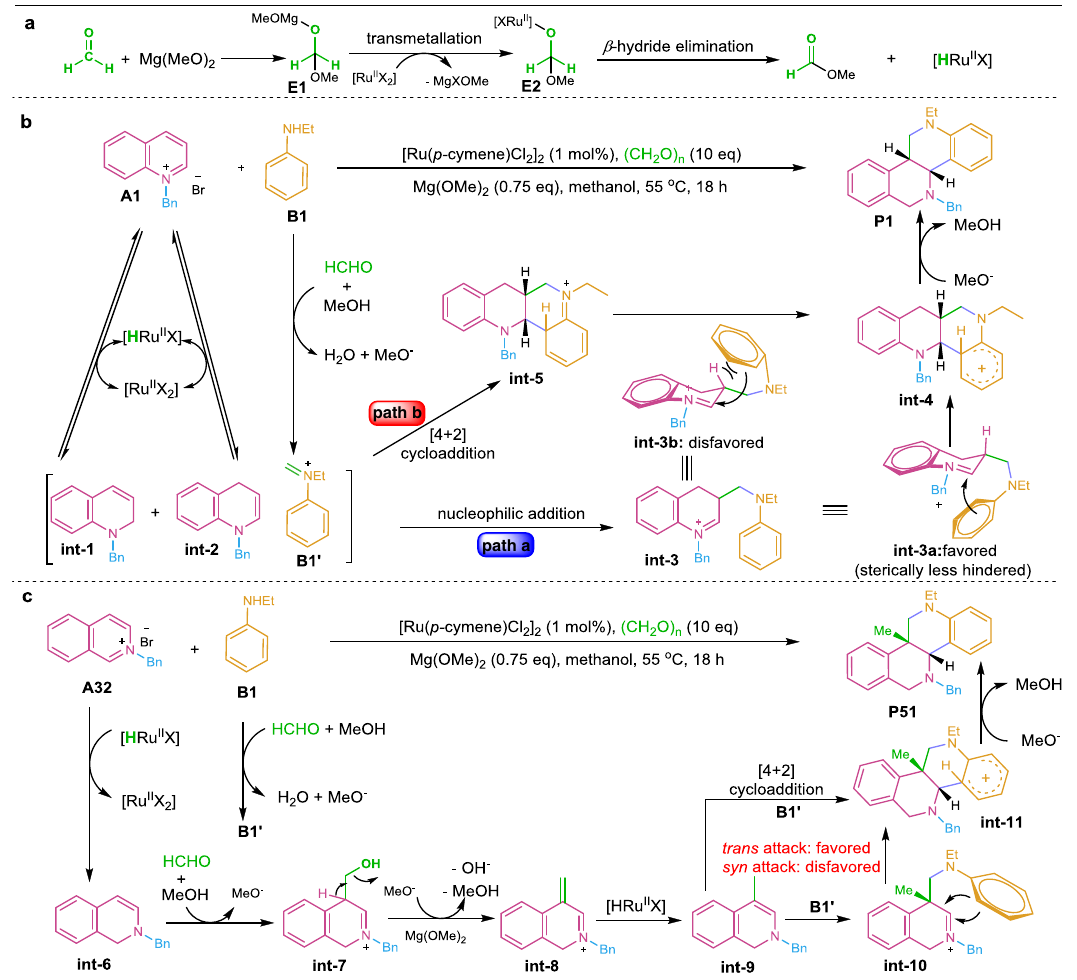
Fig. 7 Plausible reaction mechanism. a The production of metal hydride species. b Possible pathways for the formation product P1 . c Possible pathway for the formation product P51